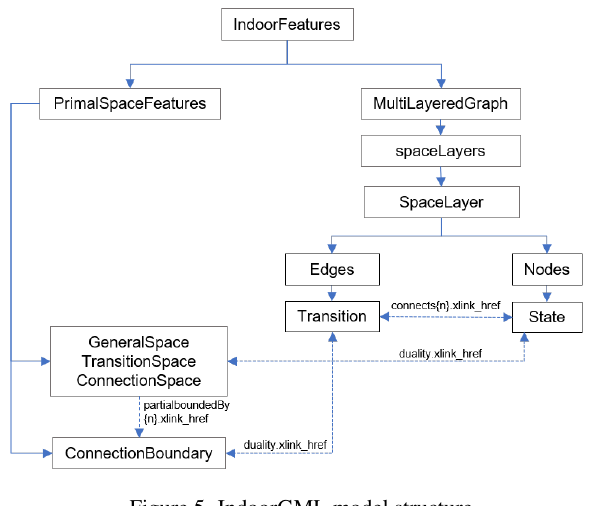
Figure 5. IndoorGML model structure